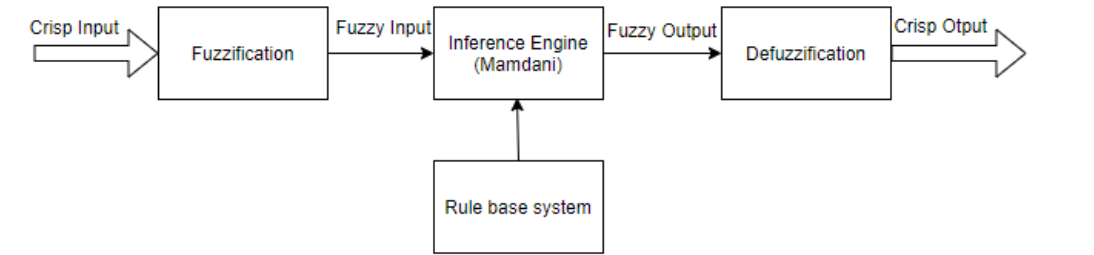
Fig. 1. Fuzzy decision-making system